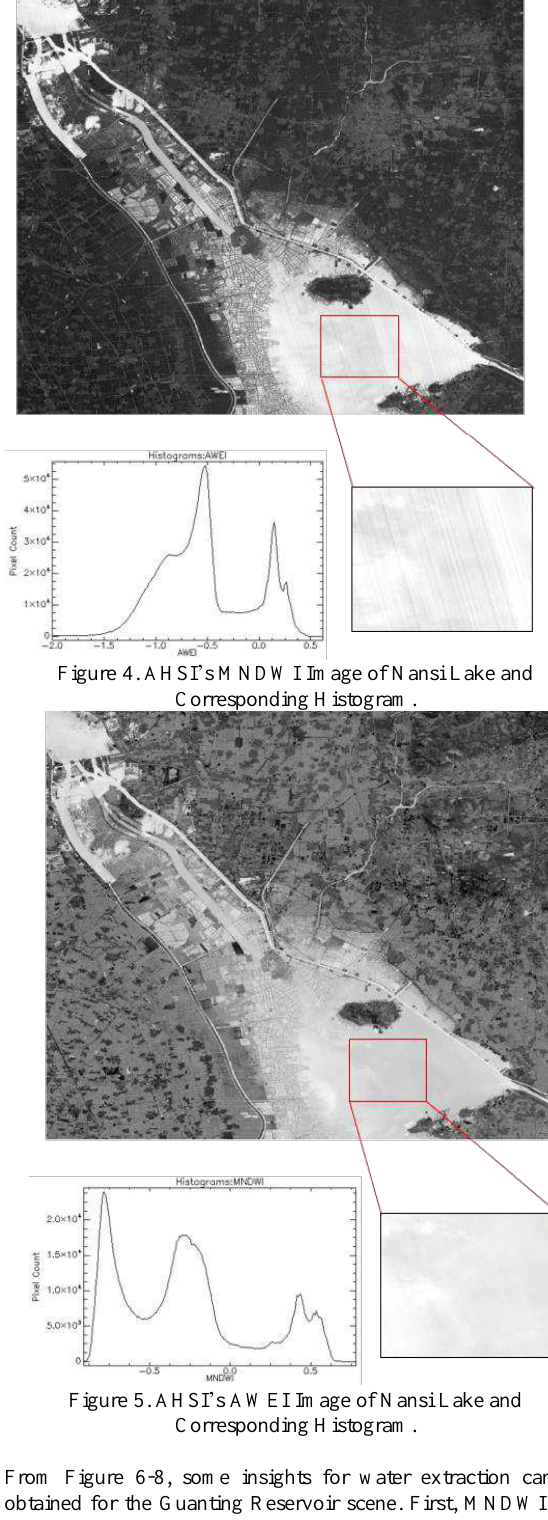
Figure 5. AHSI ’ s AWEI Image of Nansi Lake and Corresponding